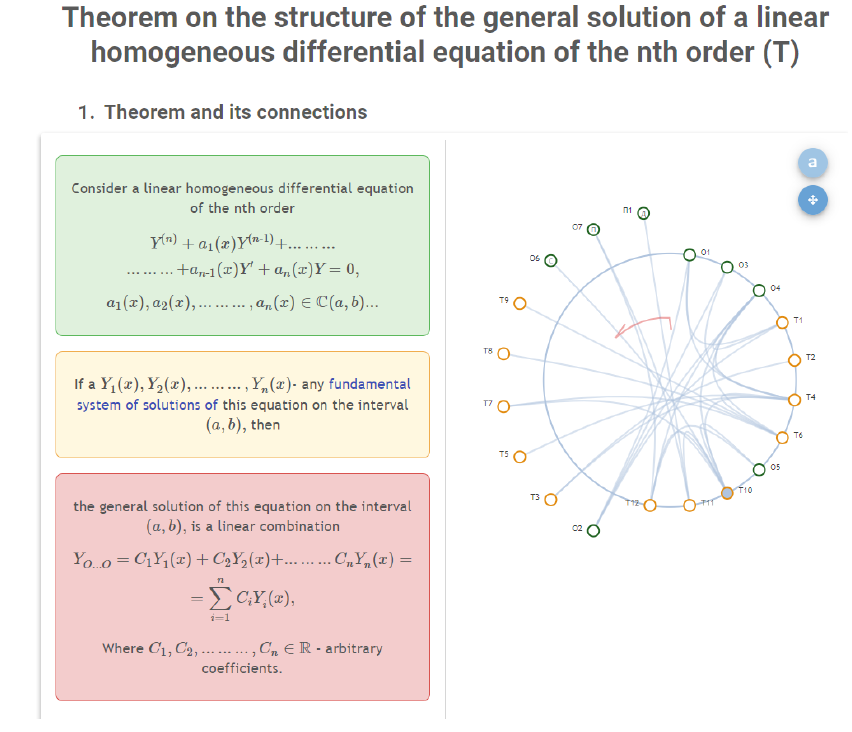
Fig. 3. Content of